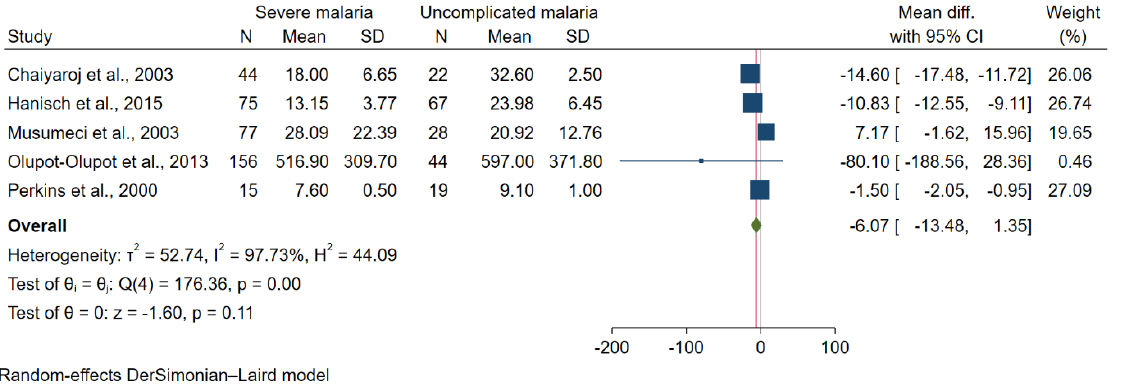
Figure 5. Forest plot demonstrating a difference in mean TGF-β levels (pg/mL) in severe and uncomplicated malaria [26,27,40–42]. Grey y -axis line, line of no effect size; blue square boxes, mean TGF-β levels from each study; line on the left and right of blue square boxes, 95% CI; green diamond; overall effect size; I 2 , H 2 and τb 2 , heterogeneity measures; test of θ, overall effect size.